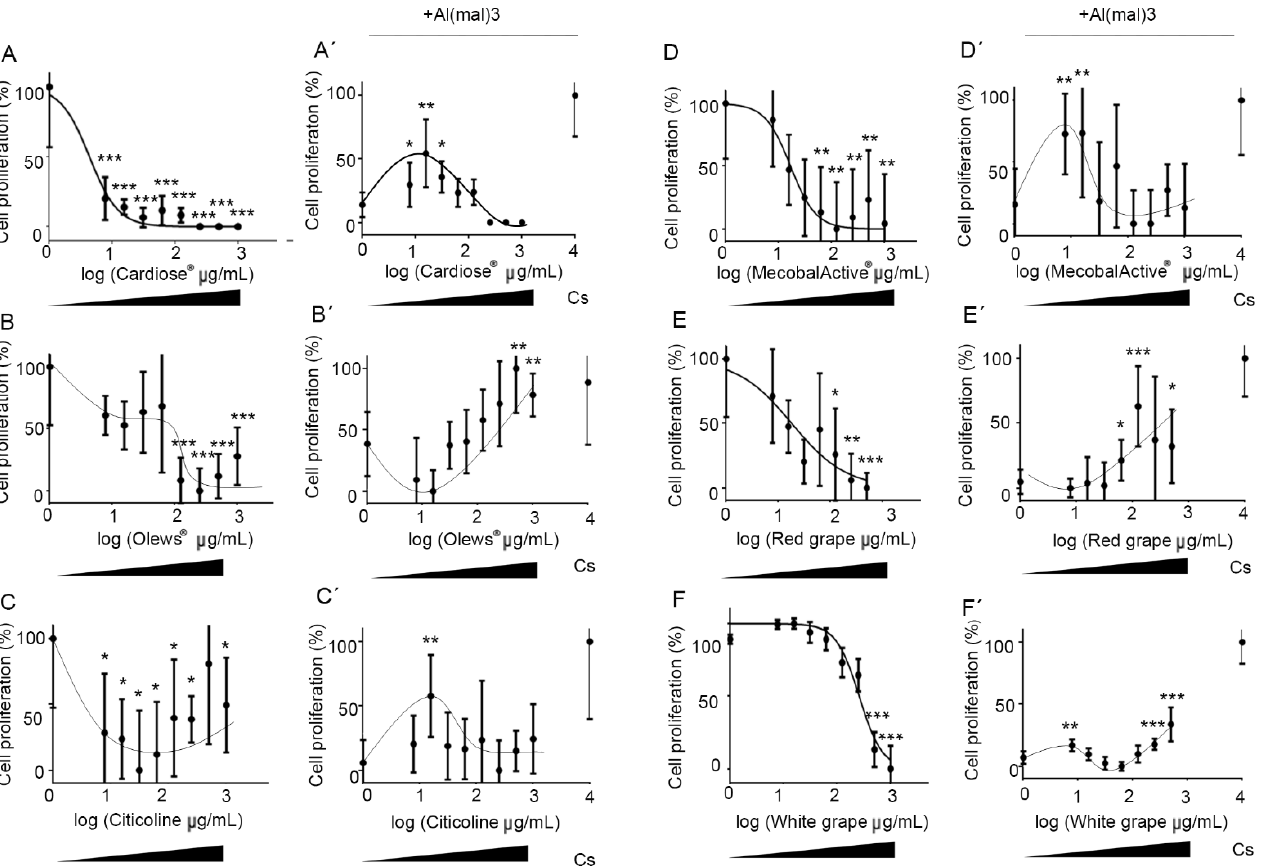
Figure 3. Neuroprotective effects of the extracts on hippocampal neuron cultures. Dose-response curves of the extracts on hippocampal neuron cultures. Cells were incubated with different concentrations of Cardiose ® ( A ), Olews ® ( B ), citicoline ( C ), MecobalActive ® ( D ), red grape ( E ), or white grape extracts ( F ) for 72 h in the absence ( A – F ) or presence ( A ′– F ′) of 125-µM Al(mal) 3 . Data are normalized and expressed as a percentage of the over-basal response (mean ± SEM). Significant differences were analyzed on data from eight different experiments; one-way ANOVA and Dunnett’s multiple comparison post-hoc test were used for statistical analysis. ∗ p < 0.05, ∗∗ p < 0.01, and ∗∗∗ p < 0.001 versus cells or Al(mal) 3 treatment. Cs: control cells, not exposed to Al(mal) 3.